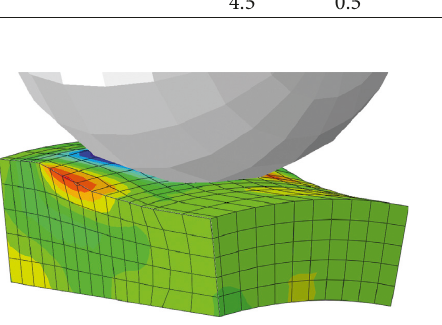
Figure 4: Deformation-affected